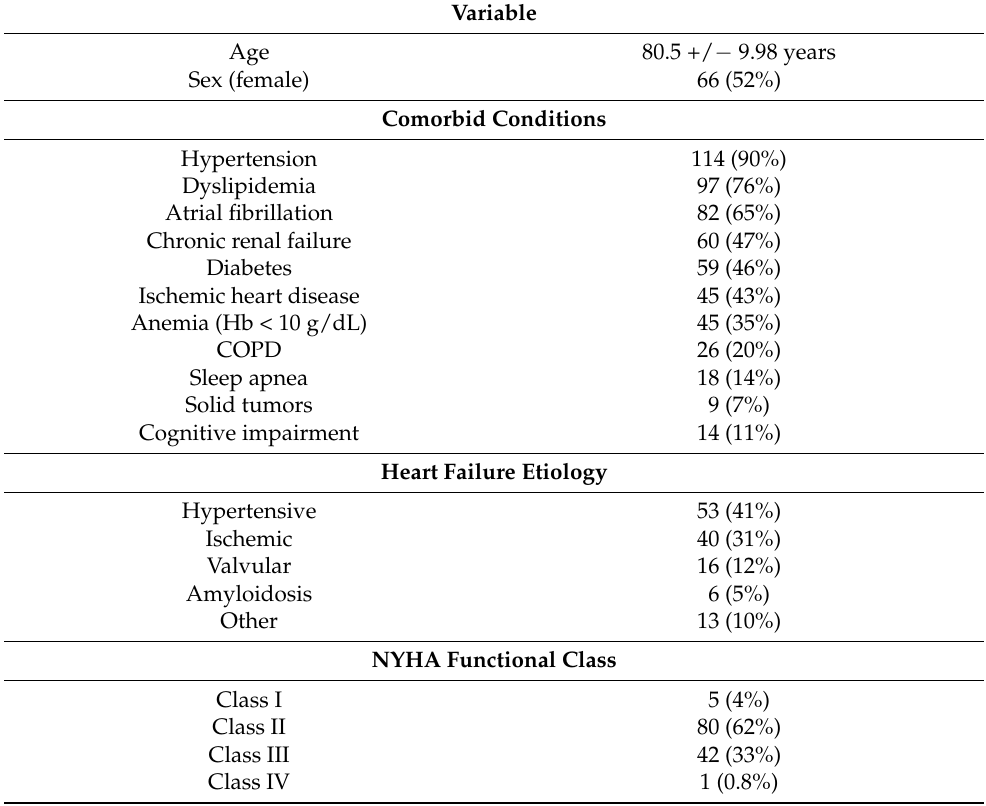
Table 2. General characteristics of patients included in the PROFUND-IC